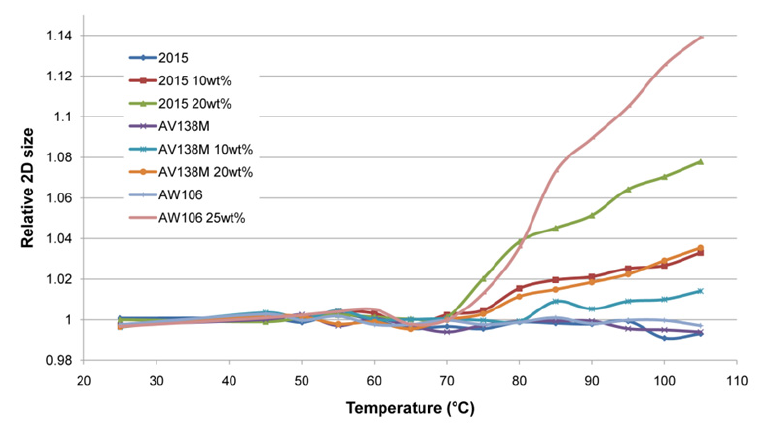
Figure 5: Expansion of neat and modified adhesives as a function of temperature.